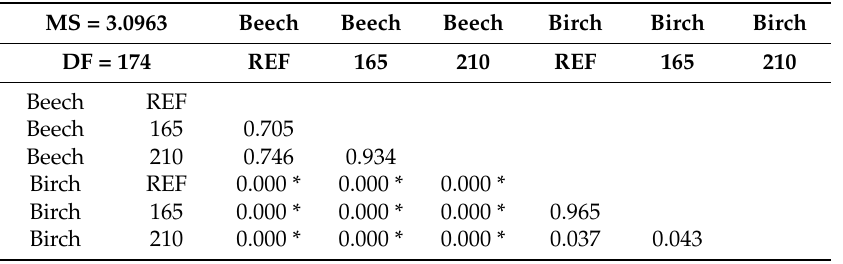
Table A2. Duncan’s Multiple Range Test for Annual Ring Width.